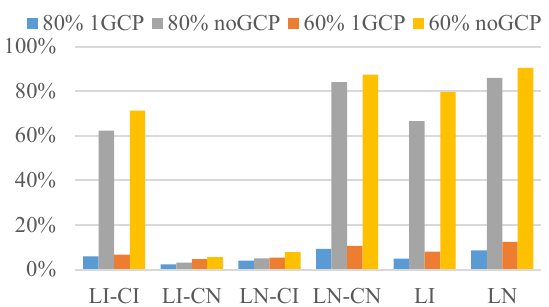
Figure 4 . Mean of Z differences as percentage of the RMSZ for the six configurations in the GNSS